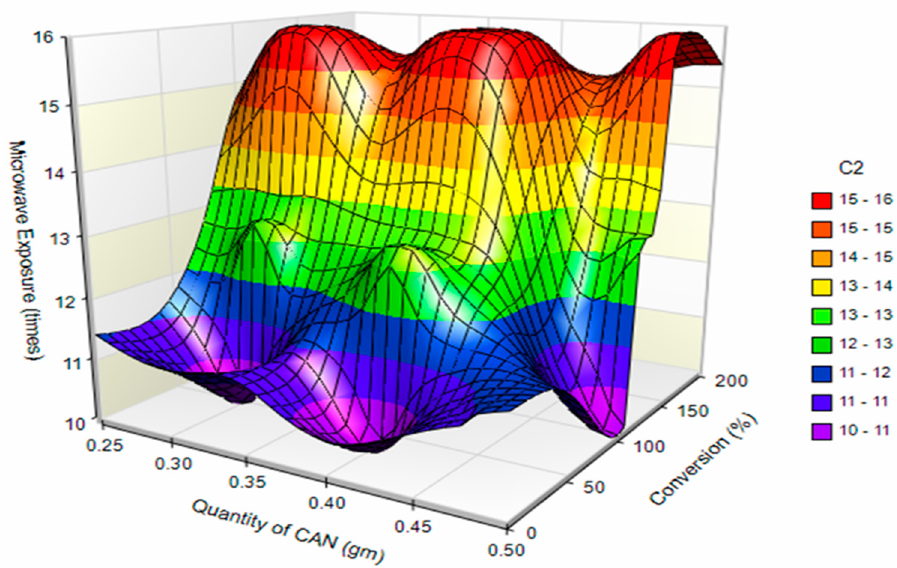
Figure 3. Surface plot for effect of independent variables on conversion of polymer .